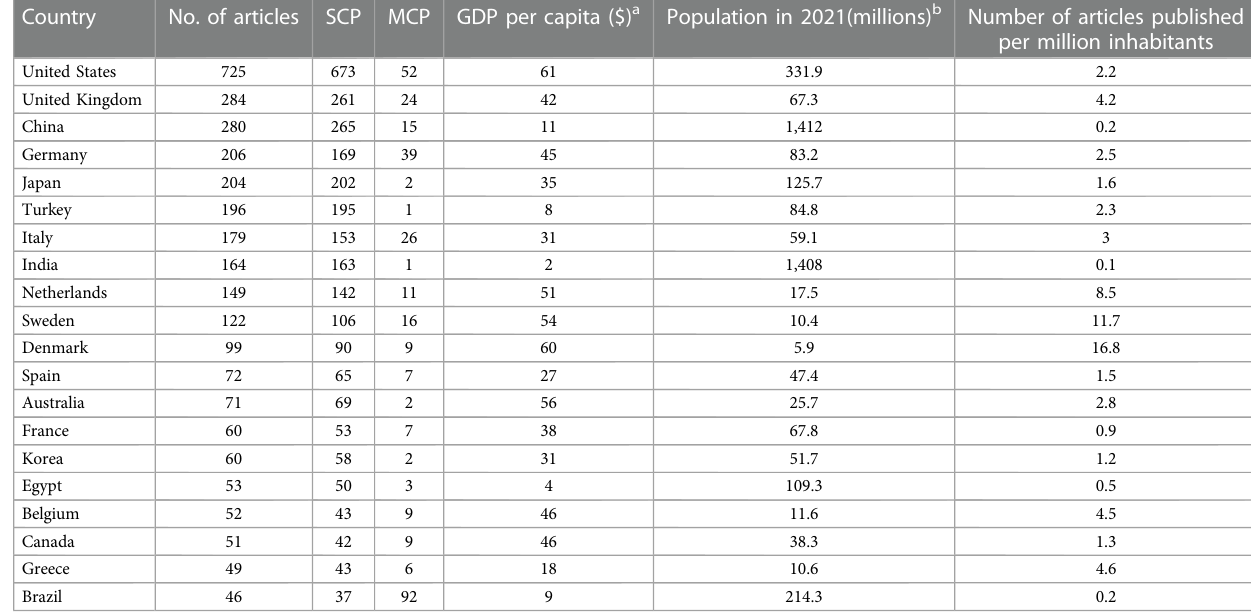
TABLE 2 The twenty corresponding author countries with the highest number of published articles. Country